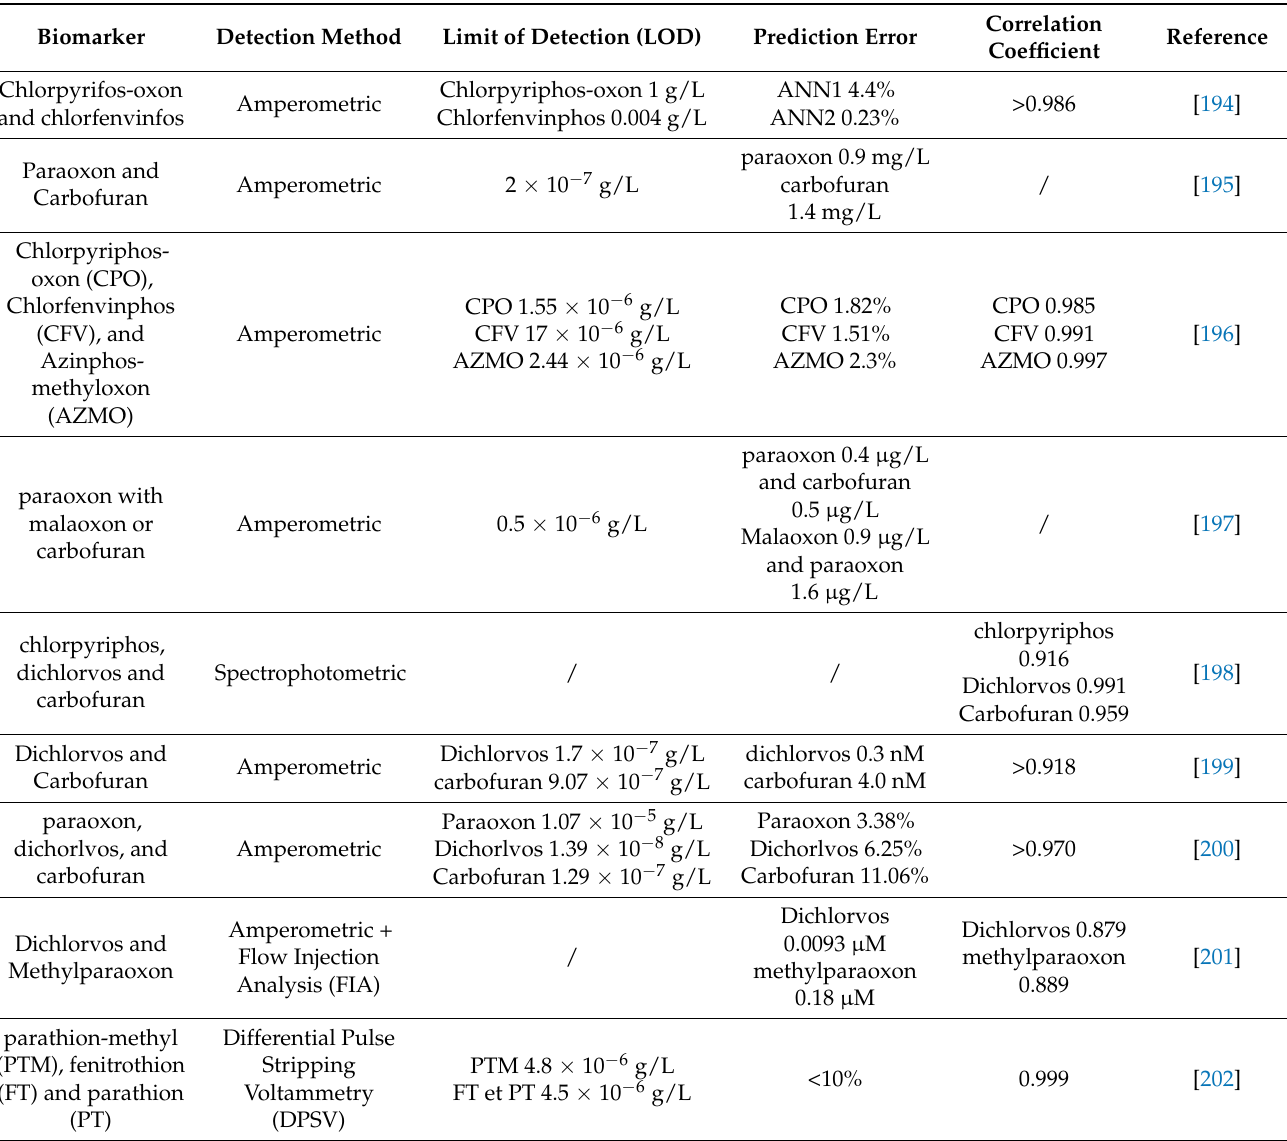
Correlation Coefficient